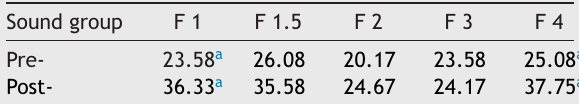
Values of DPOAE pre- and post-exposure to condi- tioning noise --- Sound group.